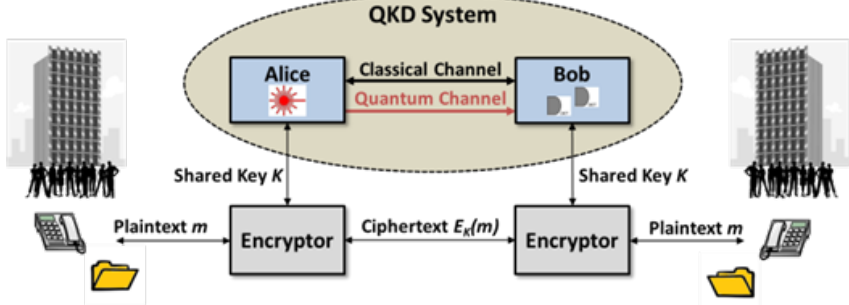
Figure 1. This is a Quantum Key Distribution (QKD) system context diagram. The sender “Alice” and receiver “Bob” generate shared secret key K for use in data encryption/decryption. Reproduced with permission from [9], Copyright IEEE, 2016.